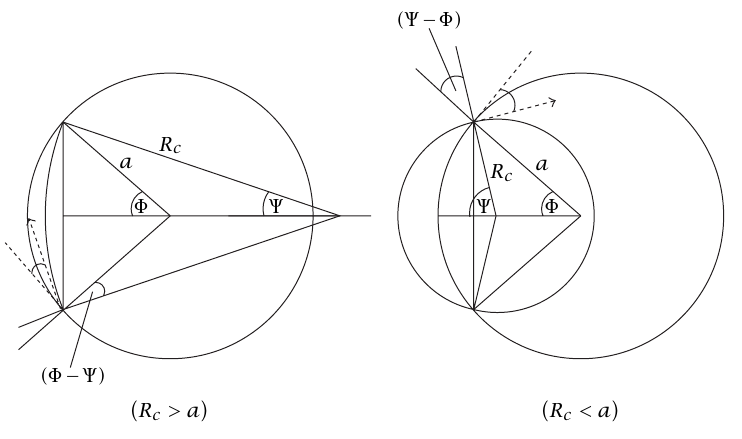
Figure B.1 . The geometry of the “ − ”